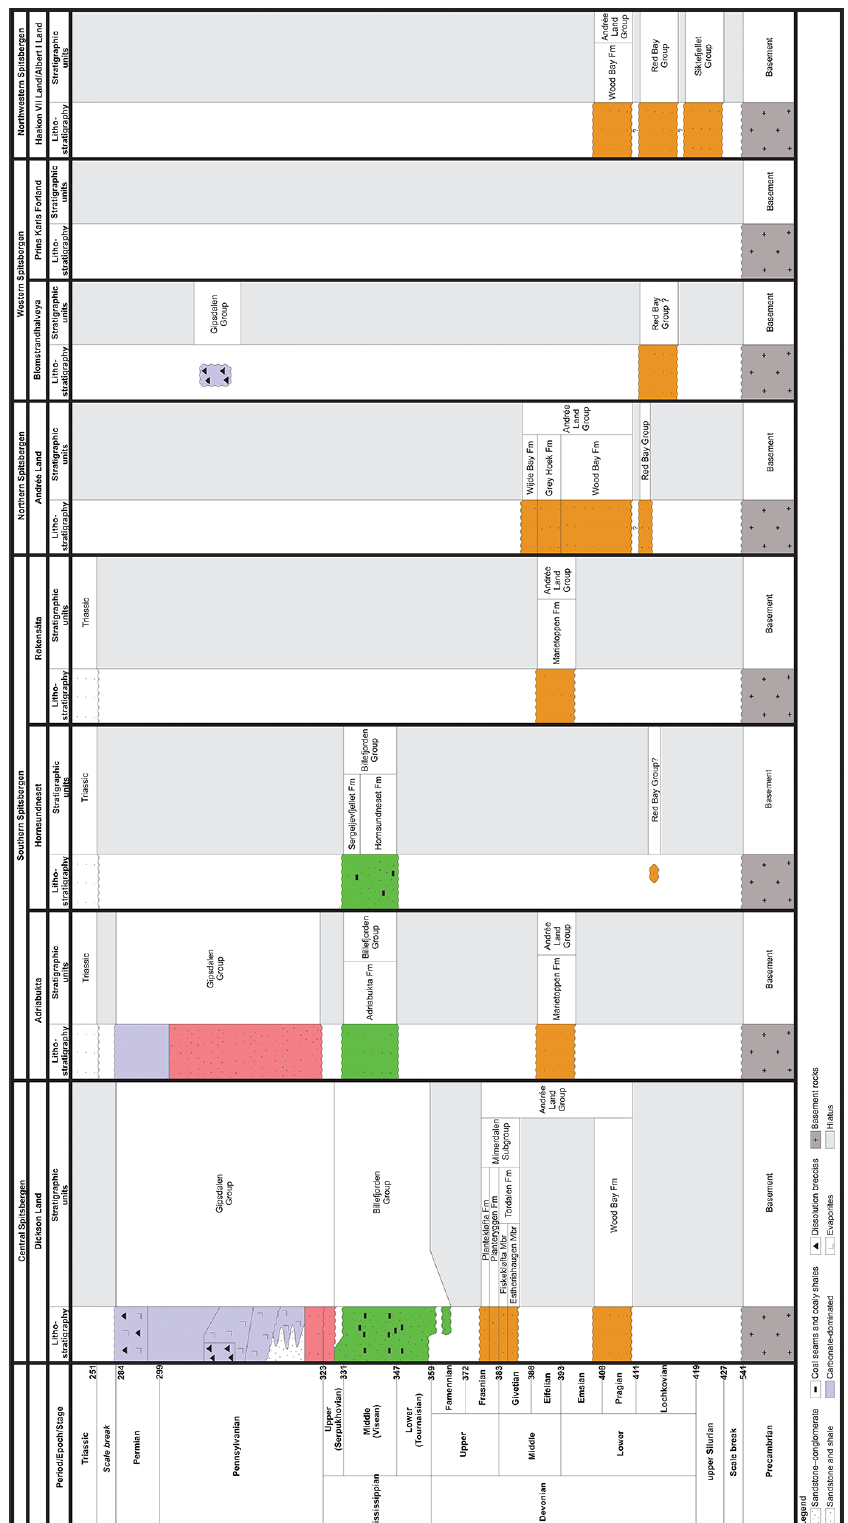
Figure 2. Late Paleozoic stratigraphic chart of the areas discussed in the text. The ages in the timescale are in Ma and are from Walker et al.